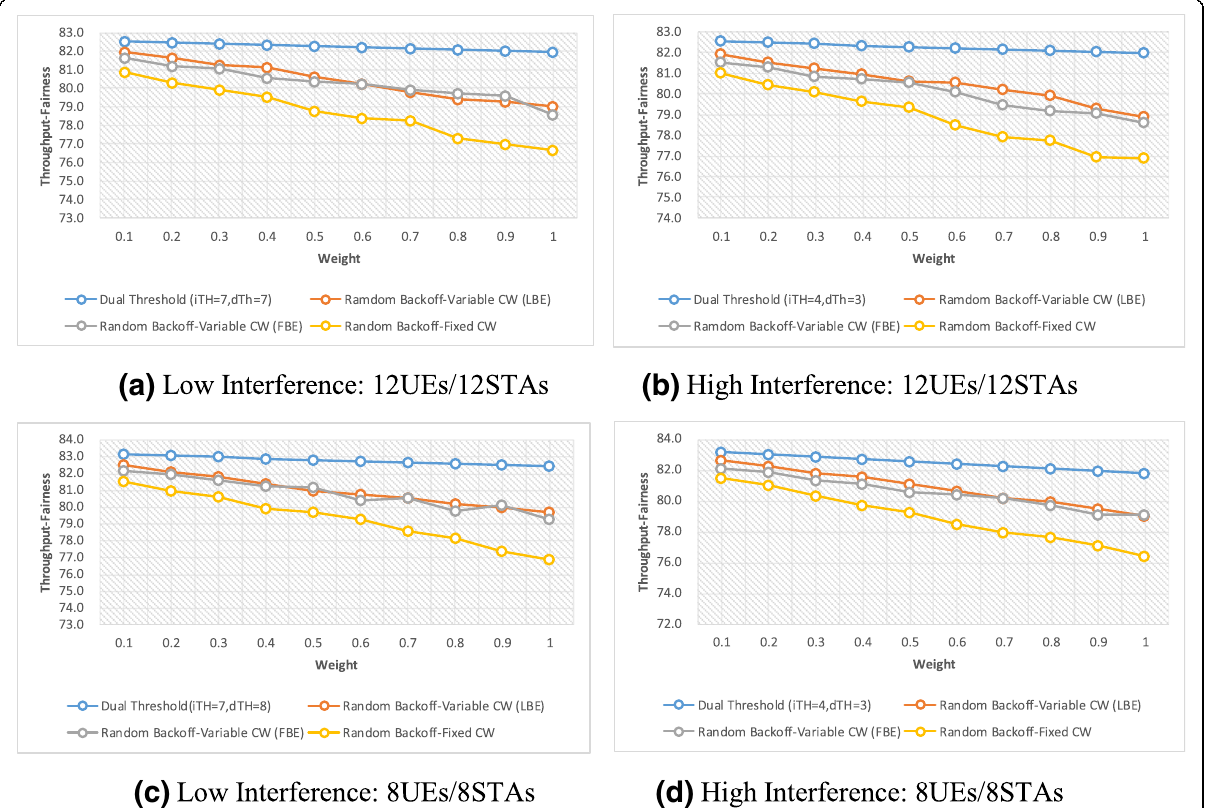
Fig. 9 Performance comparison. a Low interference: 12UEs/12STAs. b High interference: 12UEs/12STAs. c Low interference: 8UEs/8STAs. d High interference: